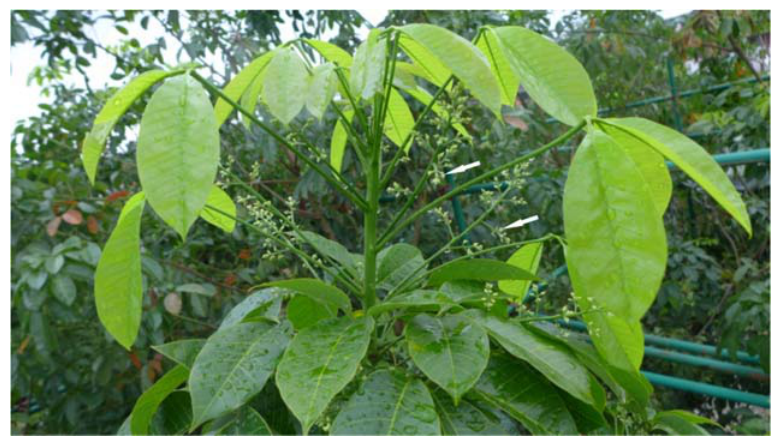
Figure 1. The suitable inflorescence material for microsporogenesis observation. Arrows show the male flower buds.